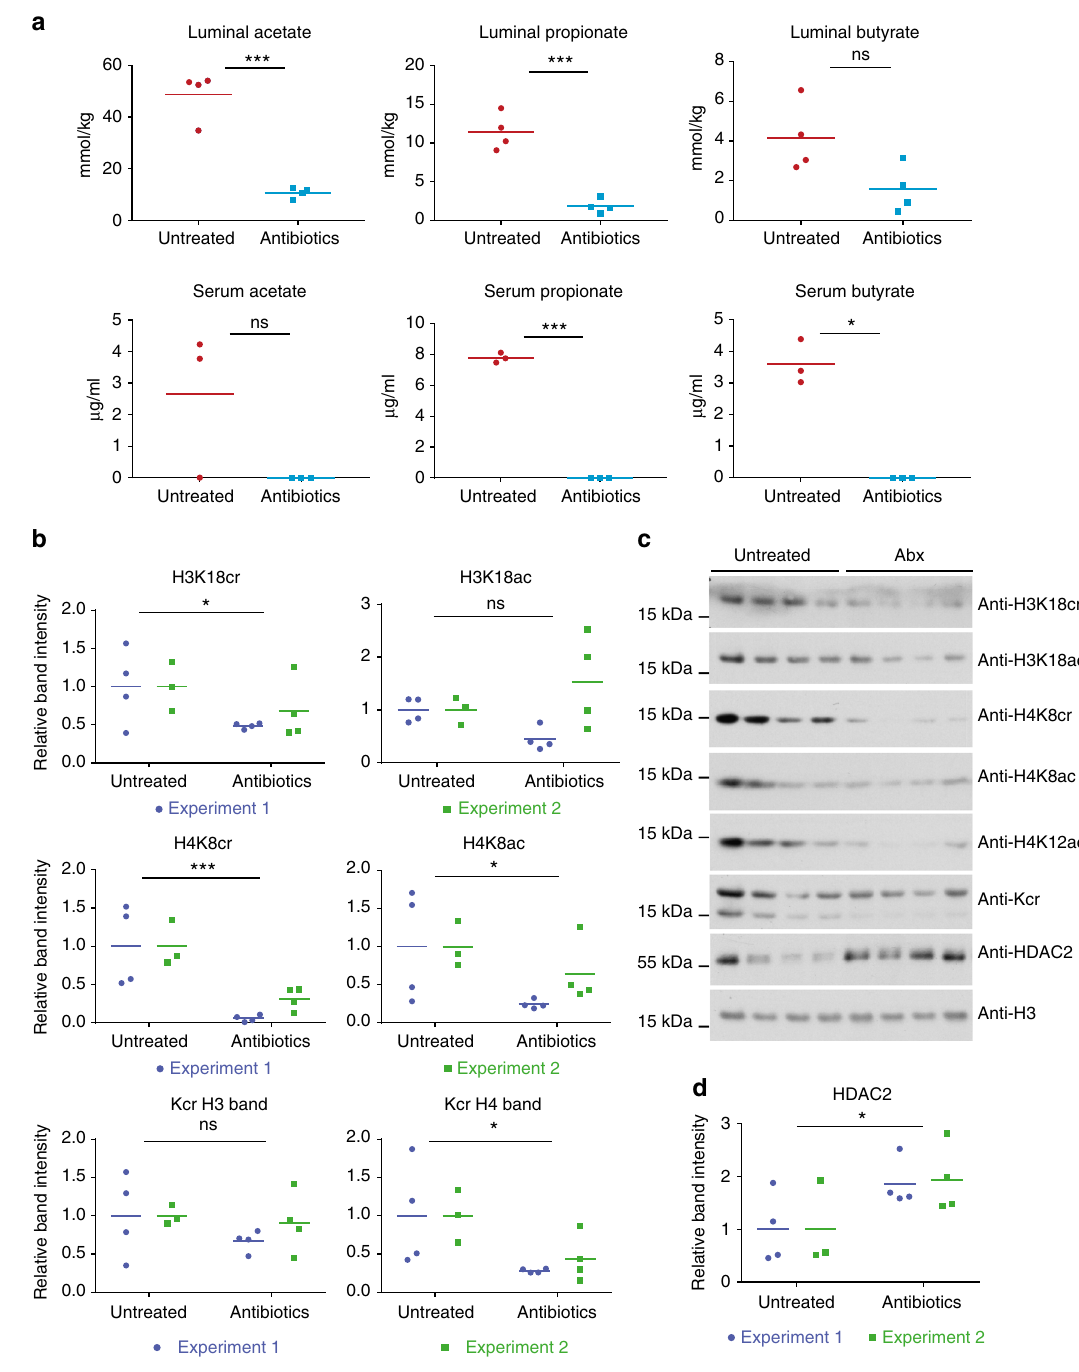
Fig. 3 Microbiota depletion affects colonic histone crotonylation and HDAC2. Antibiotic treatment led to a decrease in luminal and serum SCFA levels in mice ( n ≥ 3, from experiment 2). a Acetate, propionate, and butyrate concentrations were measured in the colon lumen and serum by gas chromatography. Unpaired t -tests were conducted, * p- value < 0.05 and *** p- value < 0.001. Values of zero were below detectable levels. b Quanti fi cations of western blot analysis of colon extracts from untreated and treated mice, n ≥ 3. Experiments 1 and 2 are repeat experiments. Center values (small bar) are the average of the treatment group relative to the untreated group. Two-way ANOVA (two-tailed) was performed on quanti fi ed bands to compare the effect of treatment for both experiments together; * corresponds to a p- value of < 0.05 and *** corresponds to < 0.001. The quanti fi cation showed a statistically signi fi cant decrease in H4 crotonylation as detected by the anti-Kcr antibody and in H4K8cr, H4K8ac, and H3K18cr levels upon antibiotics treatment. c Global changes in various colon histone crotonylation and acetylation marks and HDAC2 as seen in representative western blots of colon extracts, from experiment 1. d Two-way ANOVA was performed on quanti fi ed bands from western blotting analysis with anti-HDAC2. A statistically signi fi cant increase was observed ( p- value <